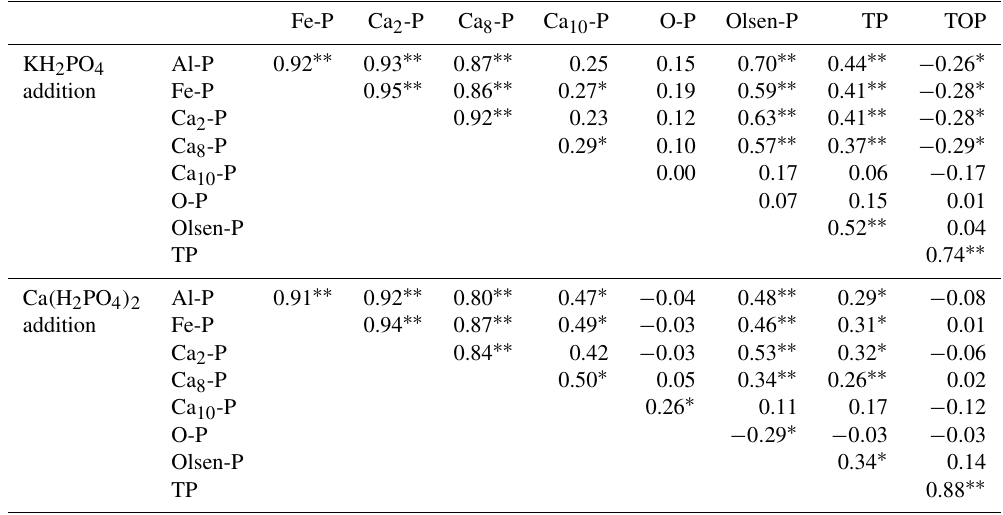
Table 3. Correlation analyses ( R values) among soil inorganic fractions, Olsen-P, total phosphorus (TP) and organic P (TOP) with Ca ( H 2 PO 4 ) 2 and KH 2 PO 4 addition in the meadow